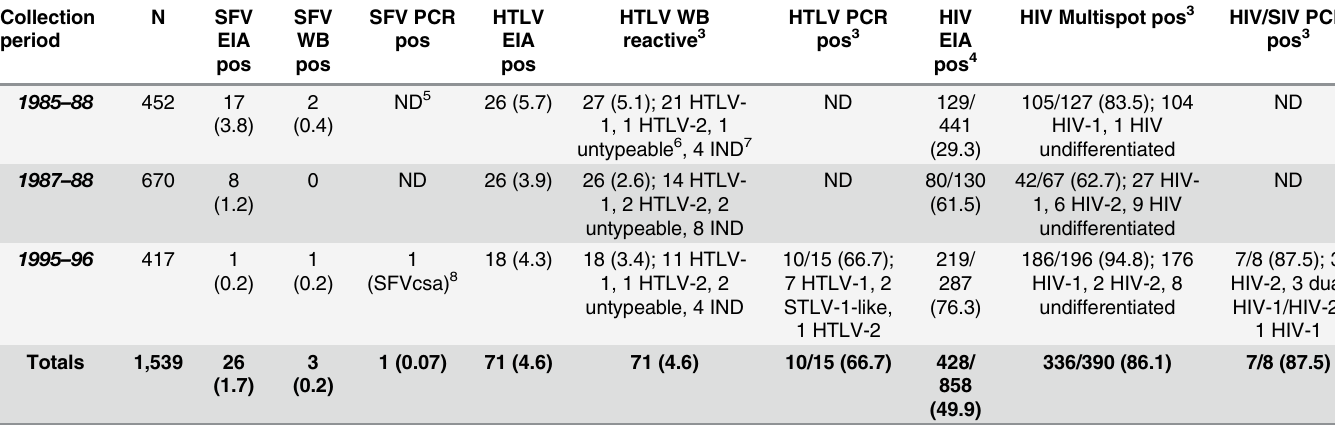
Table 1. Detection of simian and human retrovirus infections in Côte d ’ Ivoire 1985 – 1997 1,2